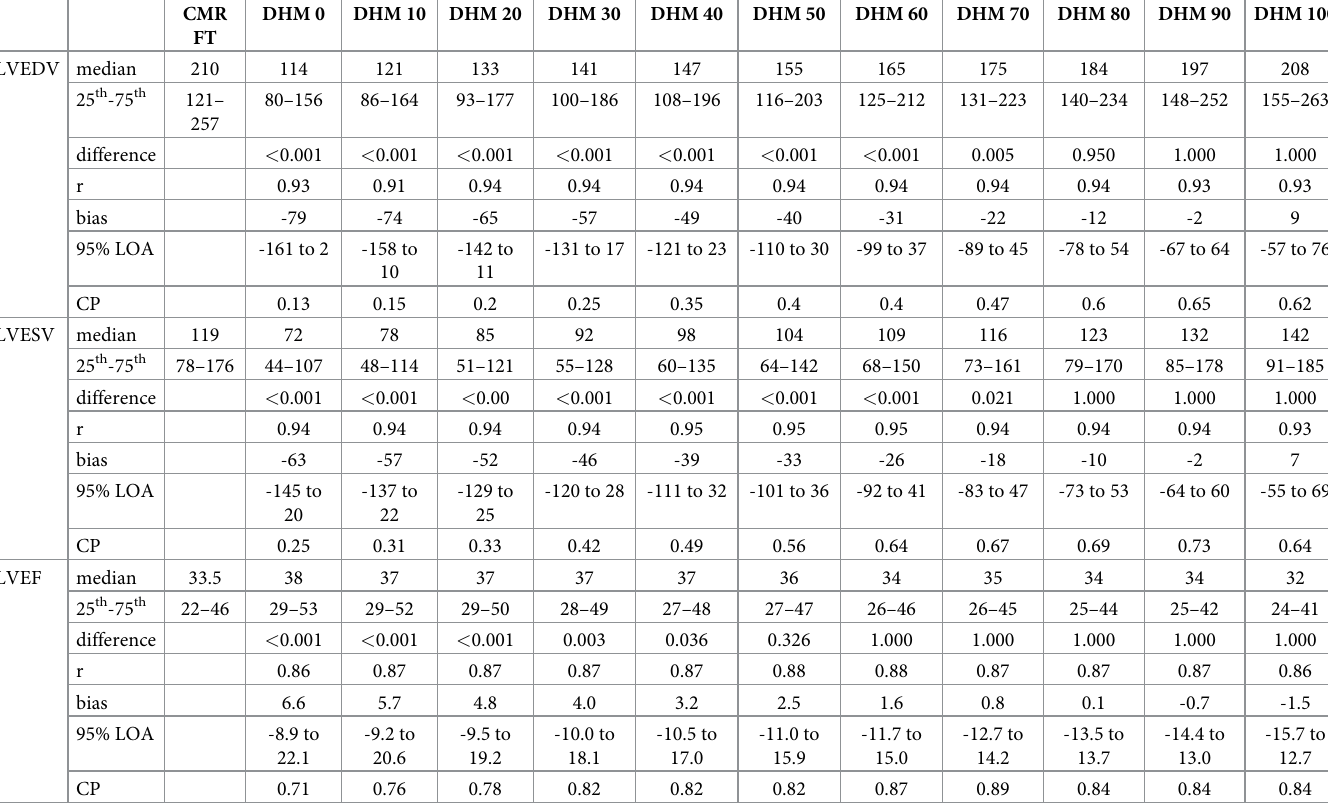
Table 3. Comparison of LV volumes and EF between Dynamic HeartModel and CMR FT method (n =